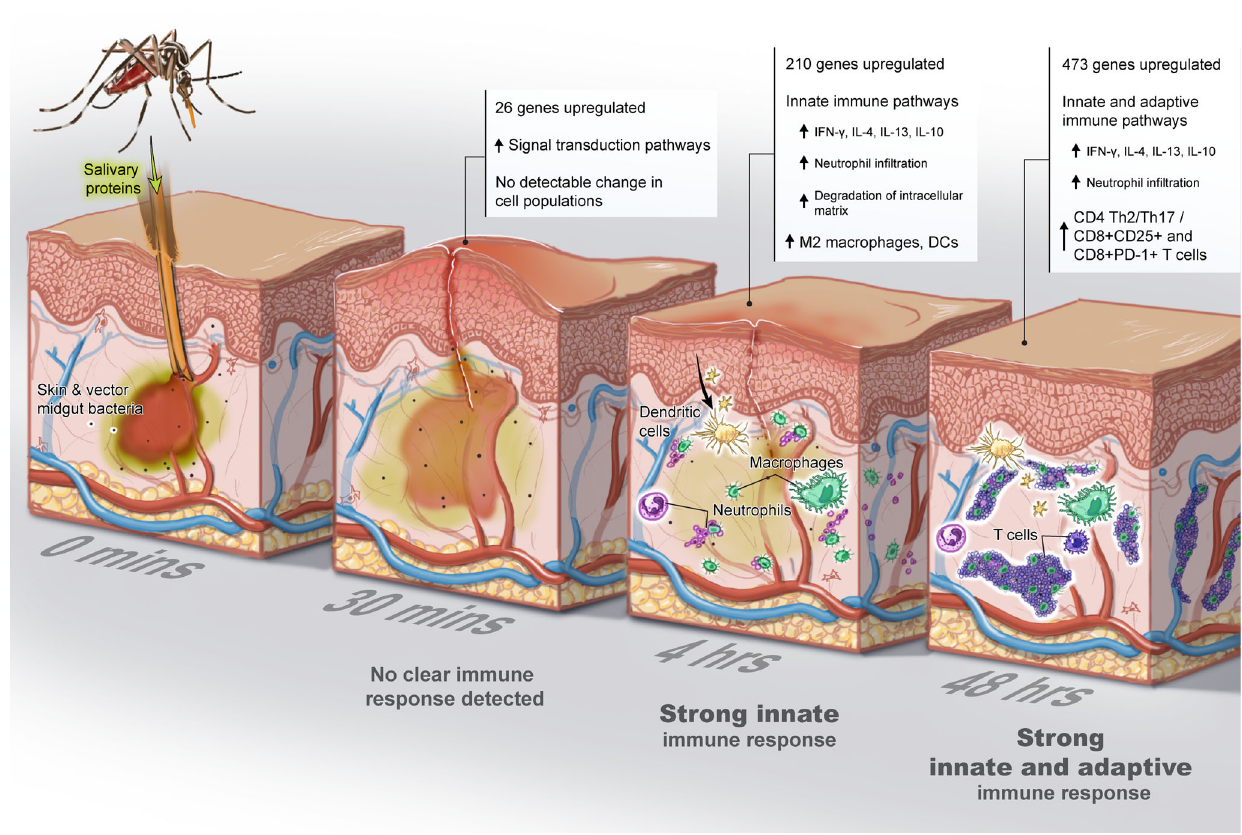
Fig. 8 | The cutaneous immune response to Aedes aegypti mosquito ‘ bites ’ evolves over time. Little activity in gene regulation and cell populations were noted at 30 min. At 4 h post-bite, a clear innate immune signature emerged followed by a strong adaptive response at 48